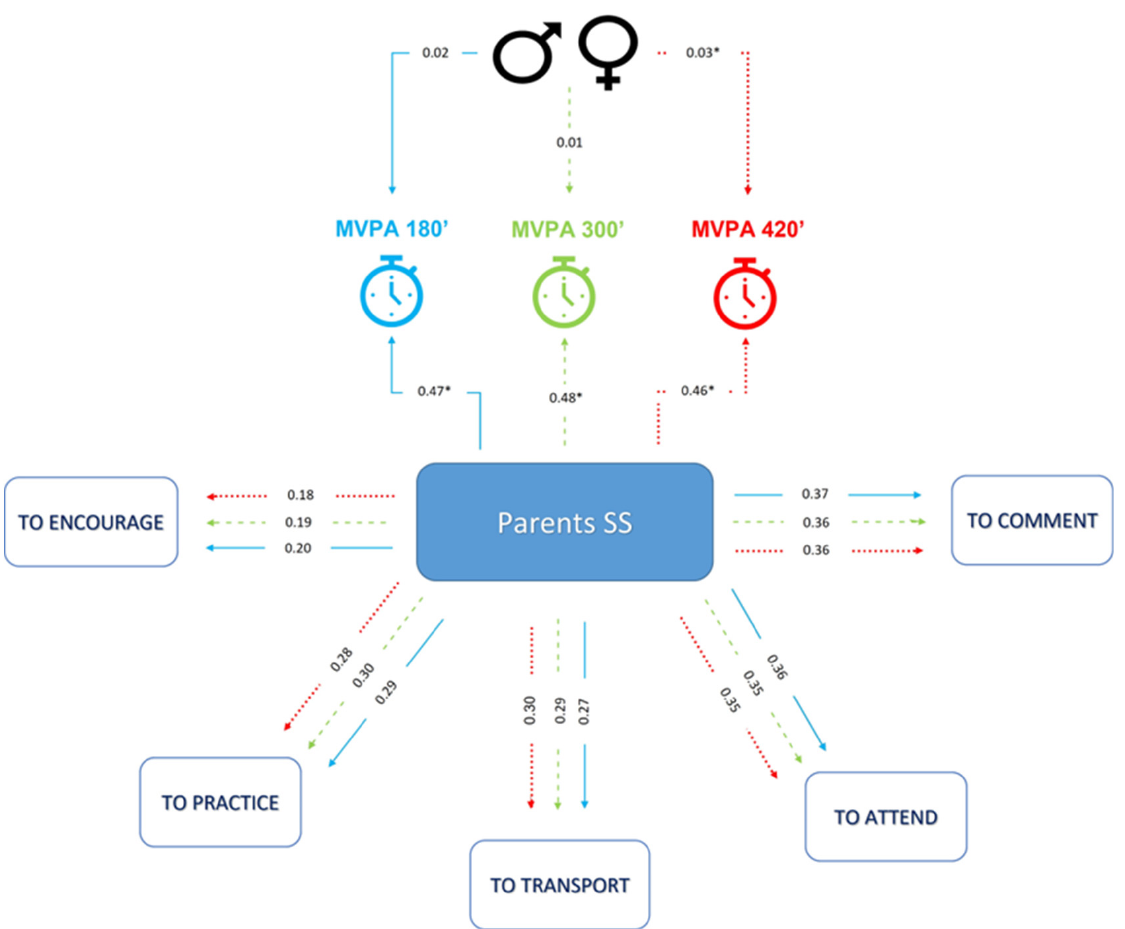
Figure 1. Association of social support received from parents with different levels of moderate-to- vigorous physical activity performed by adolescents. MVPA: moderate-to-vigorous physical activity; SS: social support. TLI and CFI > 0.9. RMSEA and SRMR < 0.08. * p value < 0.001. Social support from parents/guardians leads to an increase in the probability of performing 300 min of MVPA per week by approximately 47.8% ( p < 0.001). Gender was not significant in explaining participating (or not) in MVPA for 300 min per week. The model showed good measures for quality of fit. The TLI and CFI values above 0.9 indicate that the model was able to improve the explanatory power of MVPA variability by more than 90%. RMSEA and SRMR values less than 0.08 indicate that the model was a good fit in the sense that the residuals left by the model were low, indicating good predictive ability (Figure